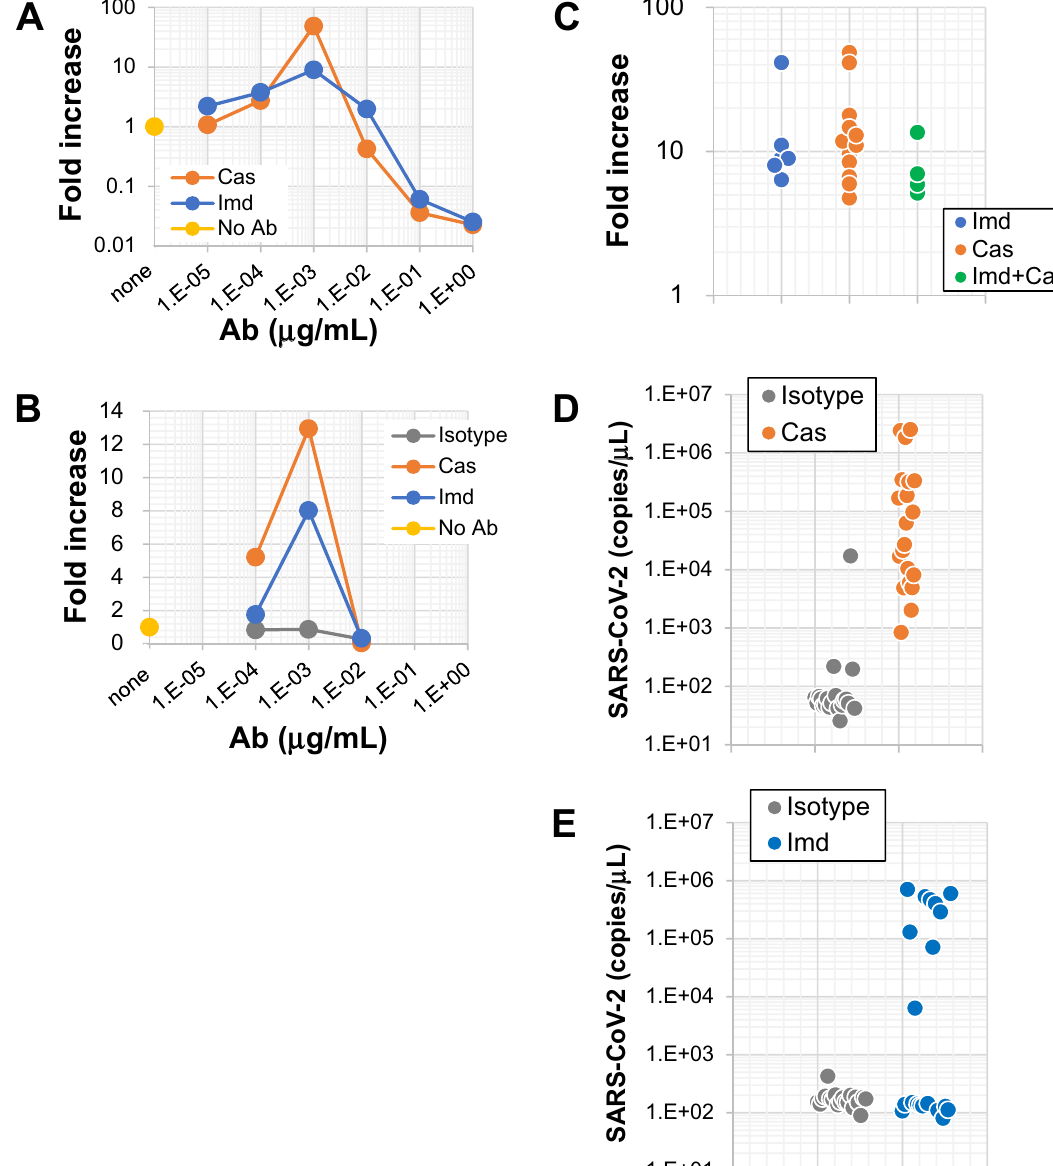
Figure 1. Anti-SARS-CoV-2 neutralizing mAbs, casirivimab and imdevimab, have the potential to cause ADE of infection. ( A , B ) Clone 35 cells (2 × 10 4 /well in a 96-well flat plate) were cultured with SARS-CoV-2 (original strain, 4 × 10 3 copies/μL) in the presence (N = 3) or absence (N = 3–6, control culture) of serially-diluted Cas, Imd, or isotype control Abs as indicated. Three days later, the amount of virus in culture SNs was measured by qPCR. The increase of virus progeny in SNs is expressed as the fold increase compared with the amount of viruses cultured in the absence of Abs. ( C ) Clone 35 cells were cultured with SARS-CoV-2 in the presence or absence of a constant dose of the indicated Abs (final 1 ng/mL each) as in ( A ). Each symbol represents individual experiments. ( D , E ) Clone 35 cells were cultured as in ( A ), but with a low dose of SARS-CoV-2 (40 copies/μL). Each symbol represents individual wells (N = 20 per